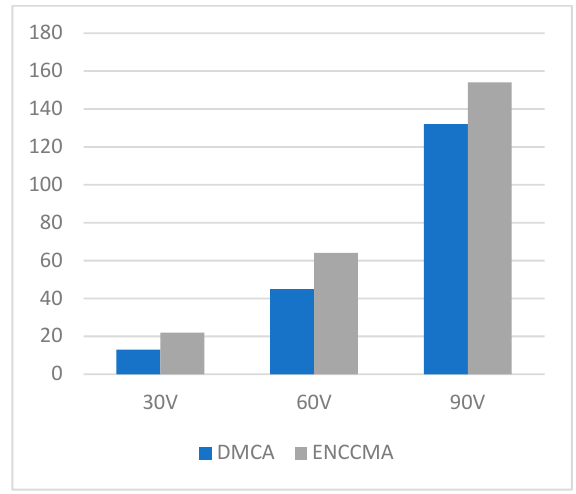
Figure 10. Data collision for highway environment.